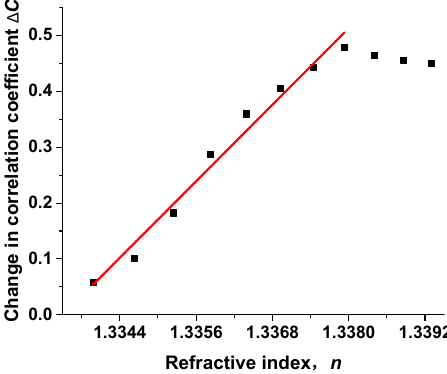
Figure 5. Sensing response for different refractive indices in the gap.